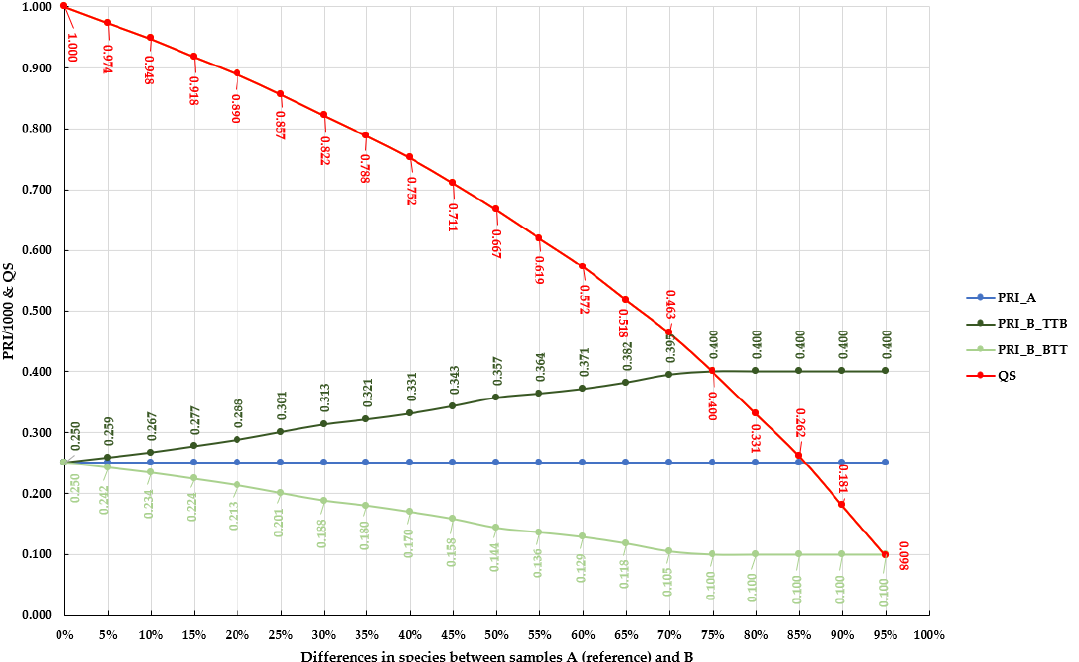
Figure 1. Aggregated results of the first case study. Legend: PRI_A —postural risk index computed for the sample A and used as a reference ( PRI_A = 250); PRI_B_TTB —postural risk index for the sample B computed following the stepwise top-to-bottom data exclusion approach; PRI_B_BTT —postural risk index for the sample B computed following the stepwise bottom-to-top data exclusion approach; QS —Sørensen’s quotient of similarity.